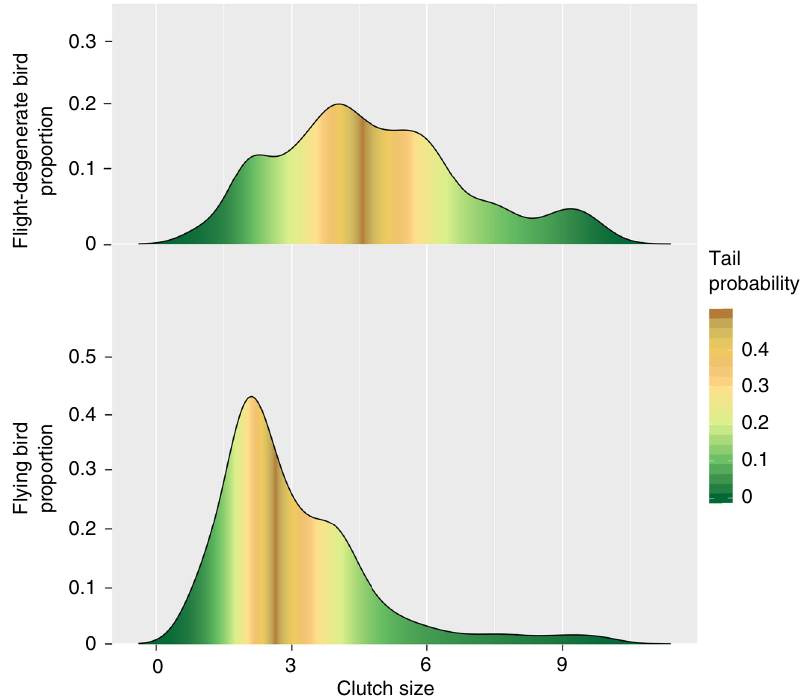
Fig. 5 Comparison of clutch sizes between fl ying and fl ight-degenerate avian species. Clutch size data of 2036 fl ying and 226 fl ight-degenerate avian species from a previous study 49 were analyzed. The x -axis means clutch size and the y -axis means the proportion of bird species. The color represents the cumulative tail probability of the distribution. Signi fi cance was assessed by a t test. Source data are provided as a Source Data fi le